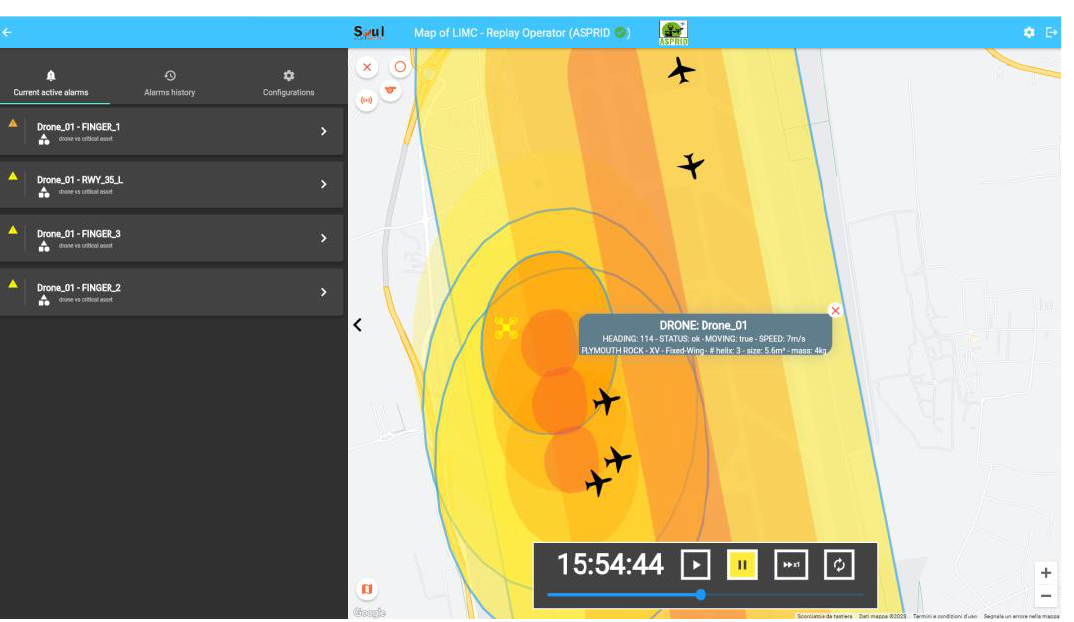
Figure 9. eArts simulator.